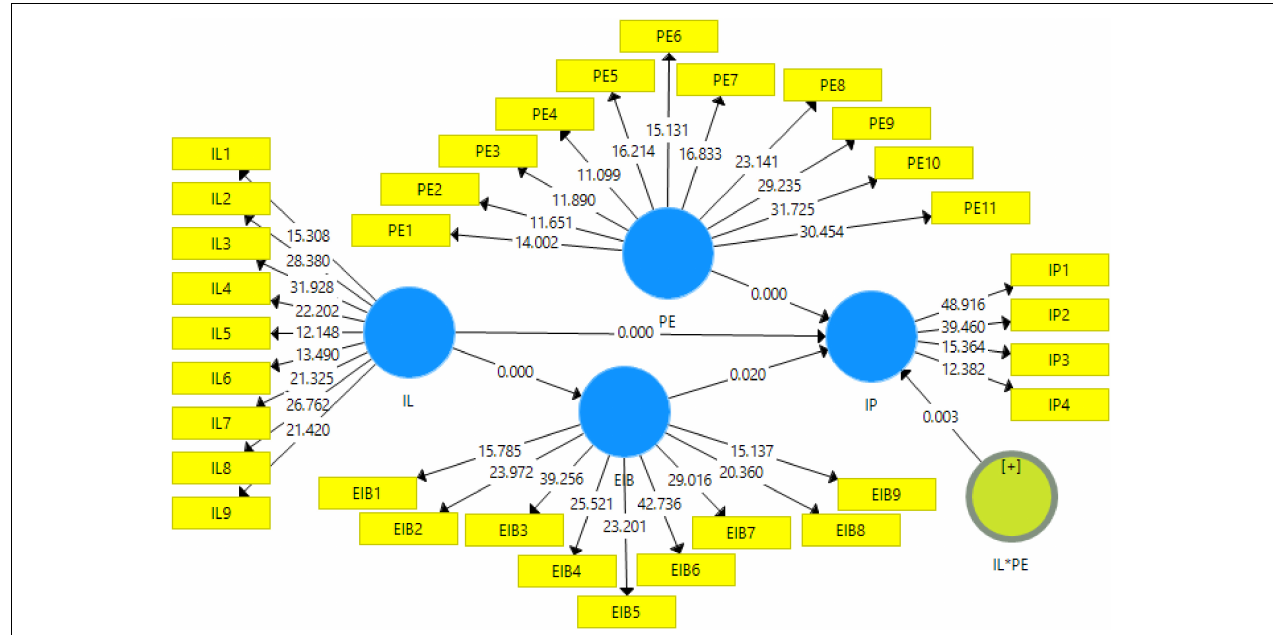
FIGURE 3 | Structural model